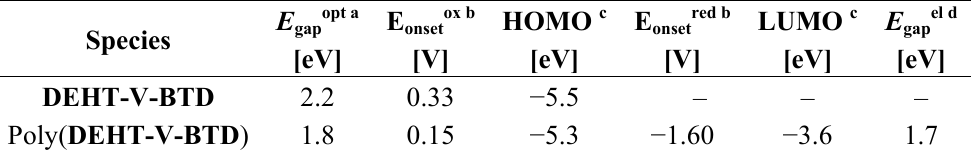
CN) properties of DEHT-V-BTD 3